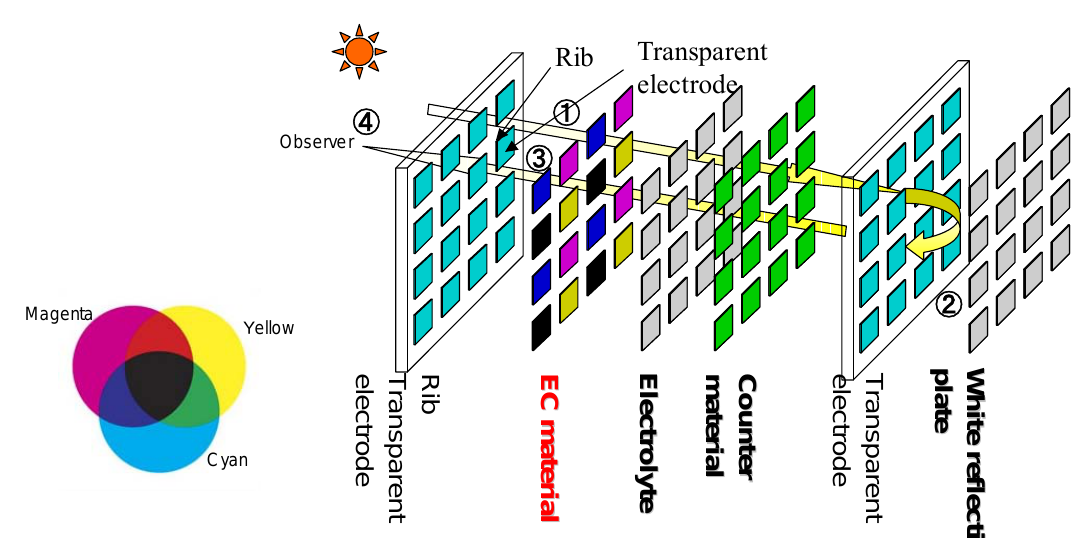
Figure 4. A structure example of EC display. Rib Transparent electrode